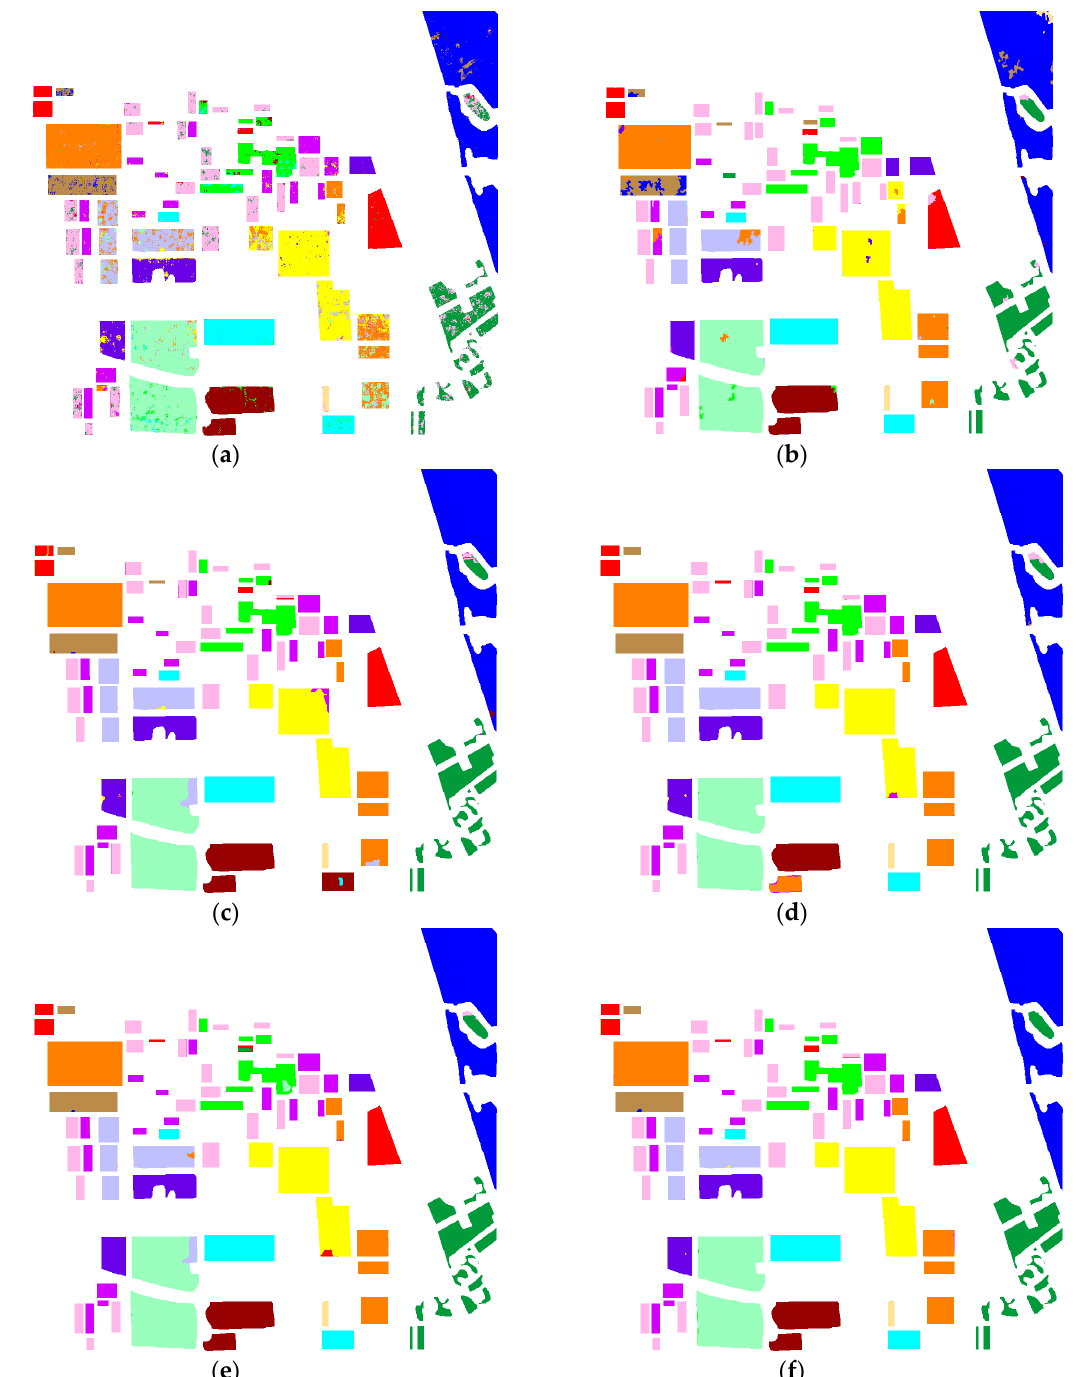
Figure 4. Classification results obtained for the AIRSAR imagery with the different strategies: ( a ) MBT_pixel; ( b ) MBT_T3; ( c ) RS; ( d ) MI; ( e ) BT; ( f ) MBT.